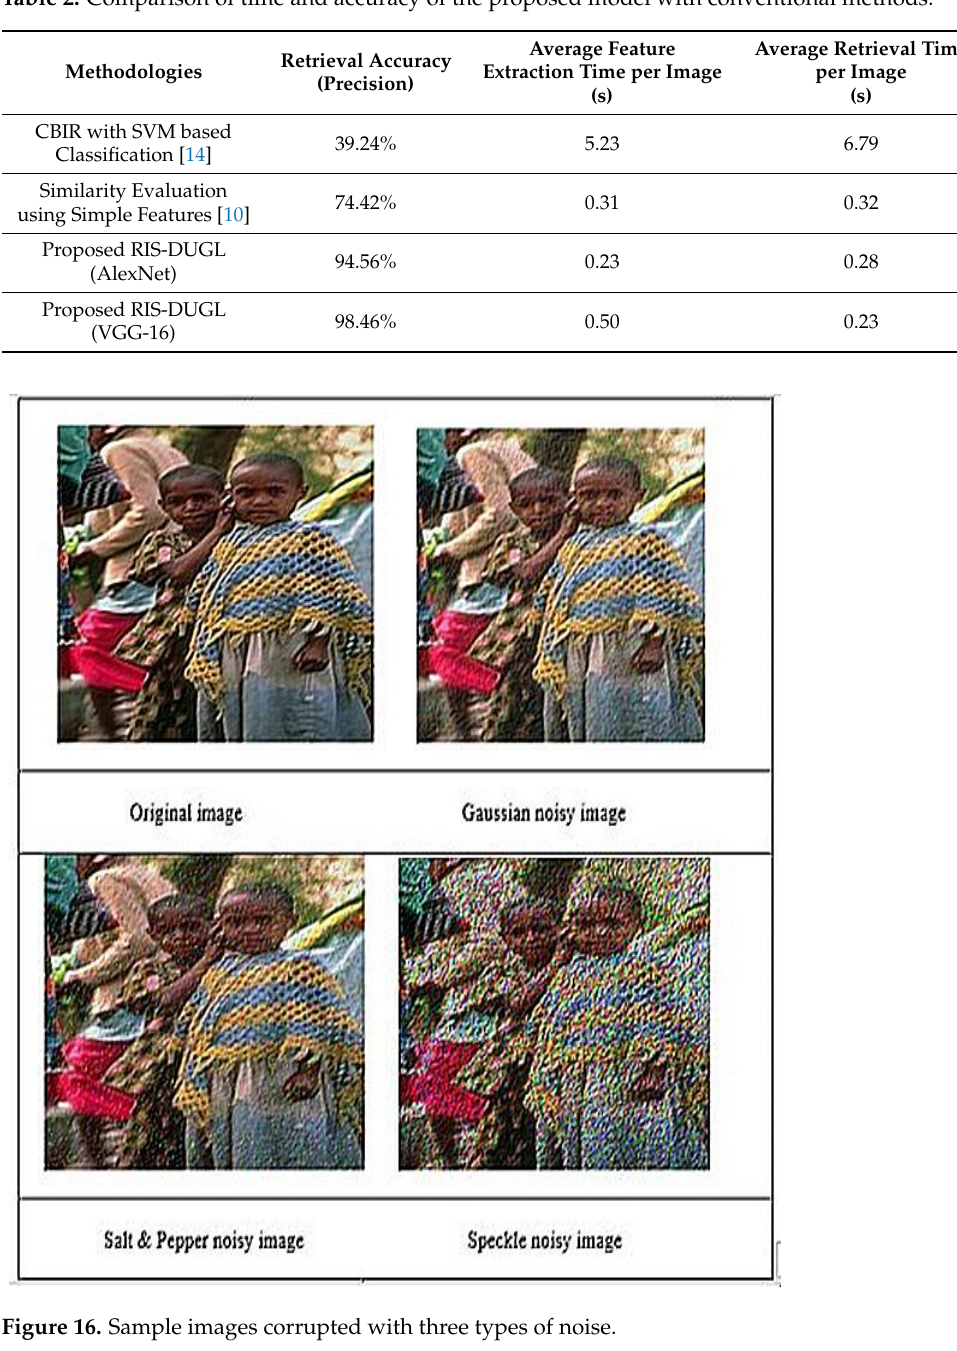
Figure 15. Results on Merchant dataset. Table 2. Comparison of time and accuracy of the proposed model with conventional methods.